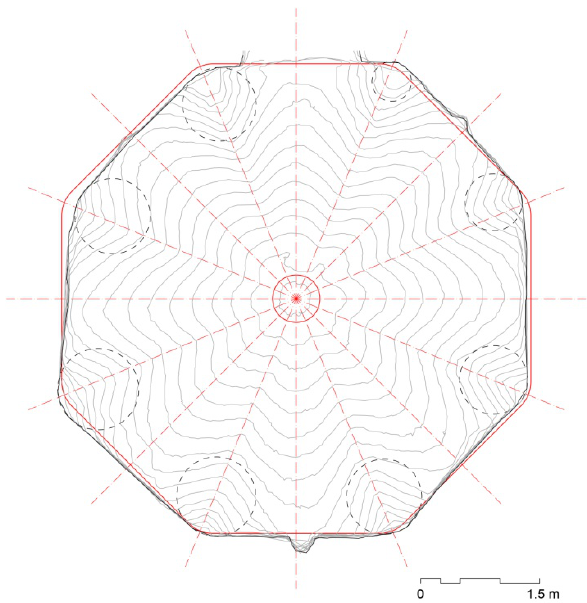
Figure 7. Plan view of the horizontal sections of the points cloud (10 cm